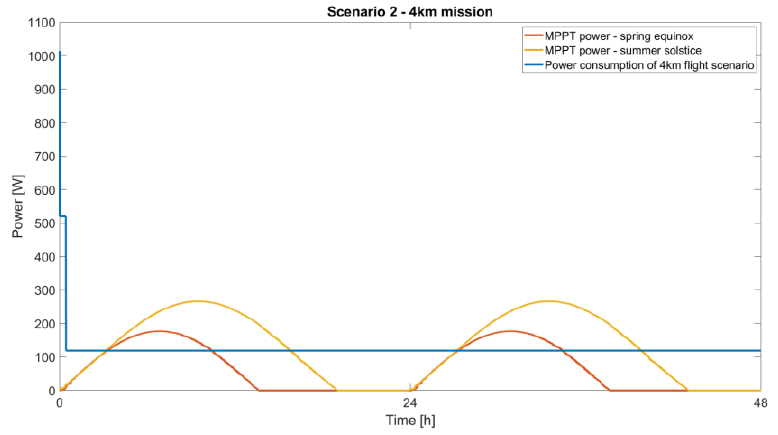
Figure 13. Power consumption and MPPT power produced by solar cells for the second scenario.